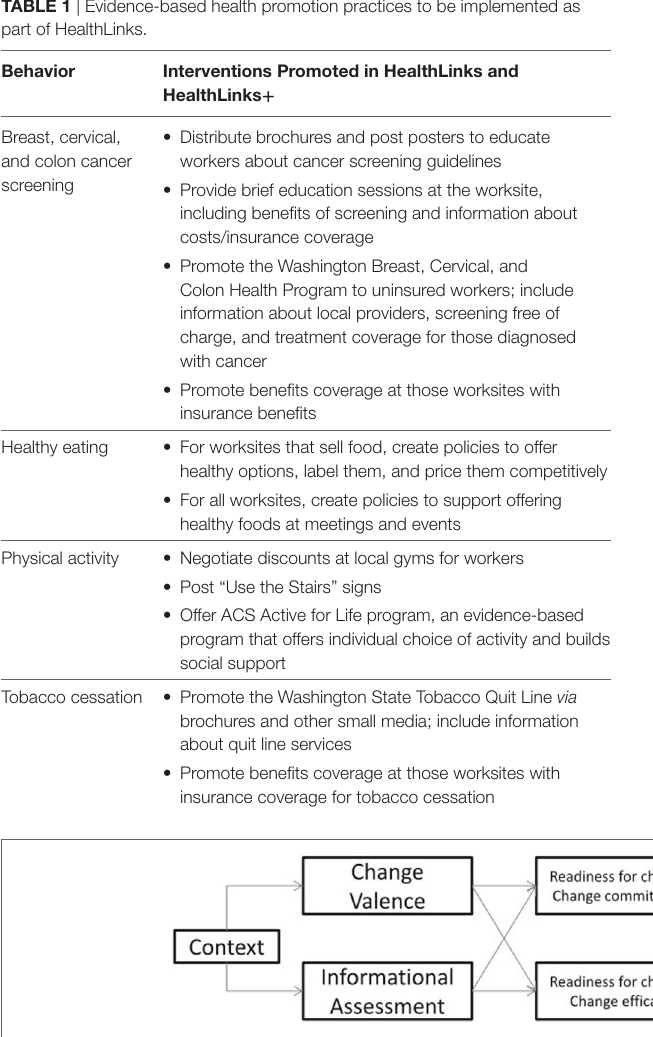
FigUre 1 | Theory of organizational readiness to change.